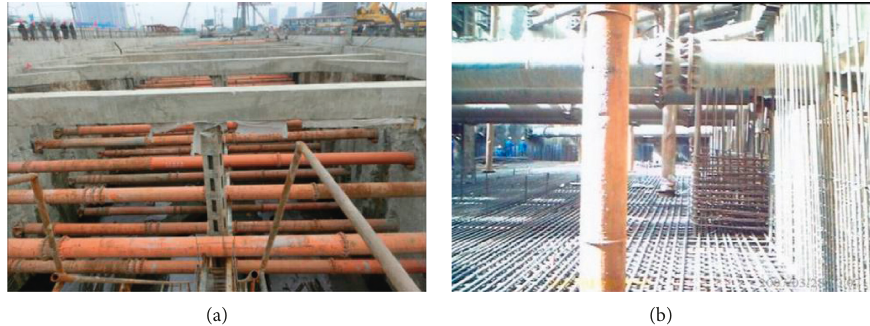
Figure 16: Field scene of JPWYRT after setting the strut. (a) Field scene on the top of pit. (b) Field scene on the bottom of pit.